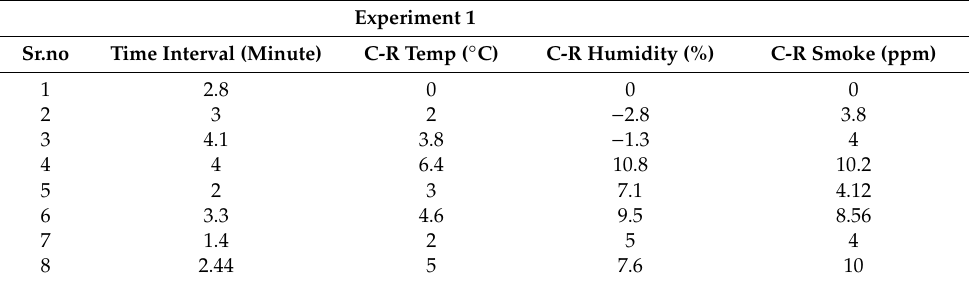
Table 2. C-R-Temp, C-R-Temp, and time of fire detection with experiment